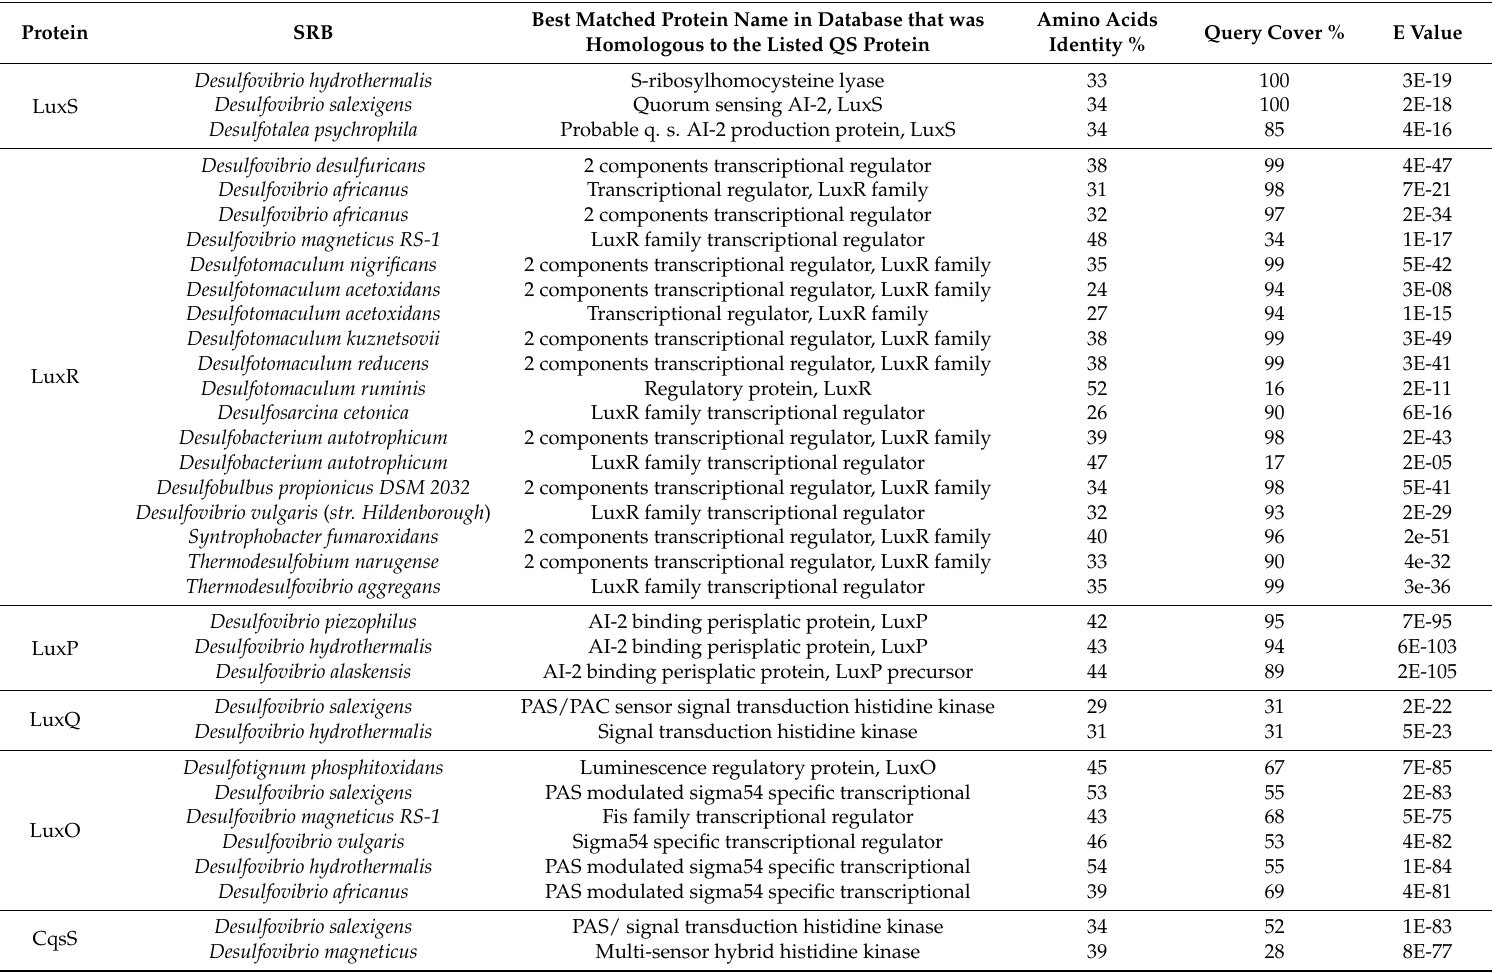
Best Matched Protein Name in Database that was Homologous to the Listed QS Protein